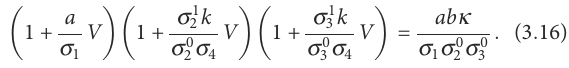
FIGURE 2 Dynamics of solutions described by system (3.1) – (3.3). If the virus replication number R v is larger than 1, the concentration of uninfected cells U ( t ) decreases, while the concentrations of infected cells W ( t ) and of virus V ( t ) fi rst increase and later decrease converging to the stationary point. All curves are normalized to their maximum. The values of parameters are as follows: a = 0.2, b = 100, k = 0.01, s 1 = 0.1, s 2 = 0.65, and s 3 =